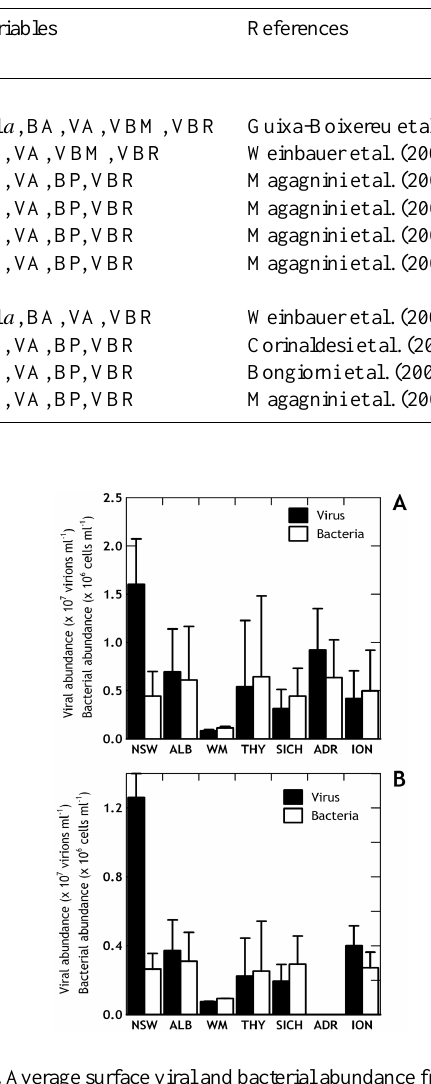
Table 3. Site, sampling data depths and variables measured and source of the studies considered in this review. S: surface, INT: integrated data, chl a : chl a concentration, BA: bacterial abundance, VA: Viral abundance, BP: bacterial production, VBR: ratio of viral abundance respect to bacterial abundance, VBM: viral mortality on bacteria, n : number of data.